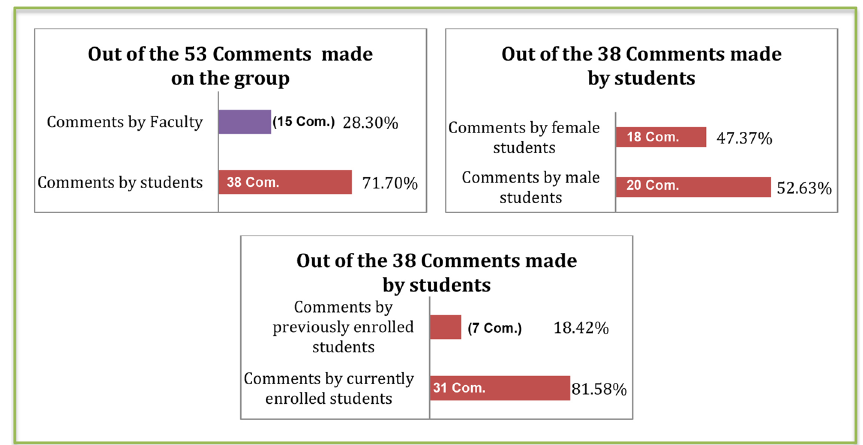
Fig. 7 Bar charts presenting the number and percentage of comments made in the group in regards of “Who” made